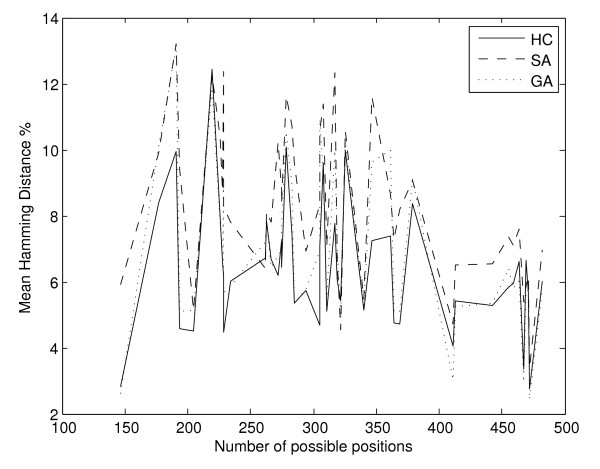
Mean hamming distance between allocations per experiment, according to number of possible genes to pathways allocations. Experiments are ordered according to the number of possible genes to pathways allocations. There appears to be very small correlation between the mean hamming distance in terms of percentage between separate runs of each search method and the size of the search space.